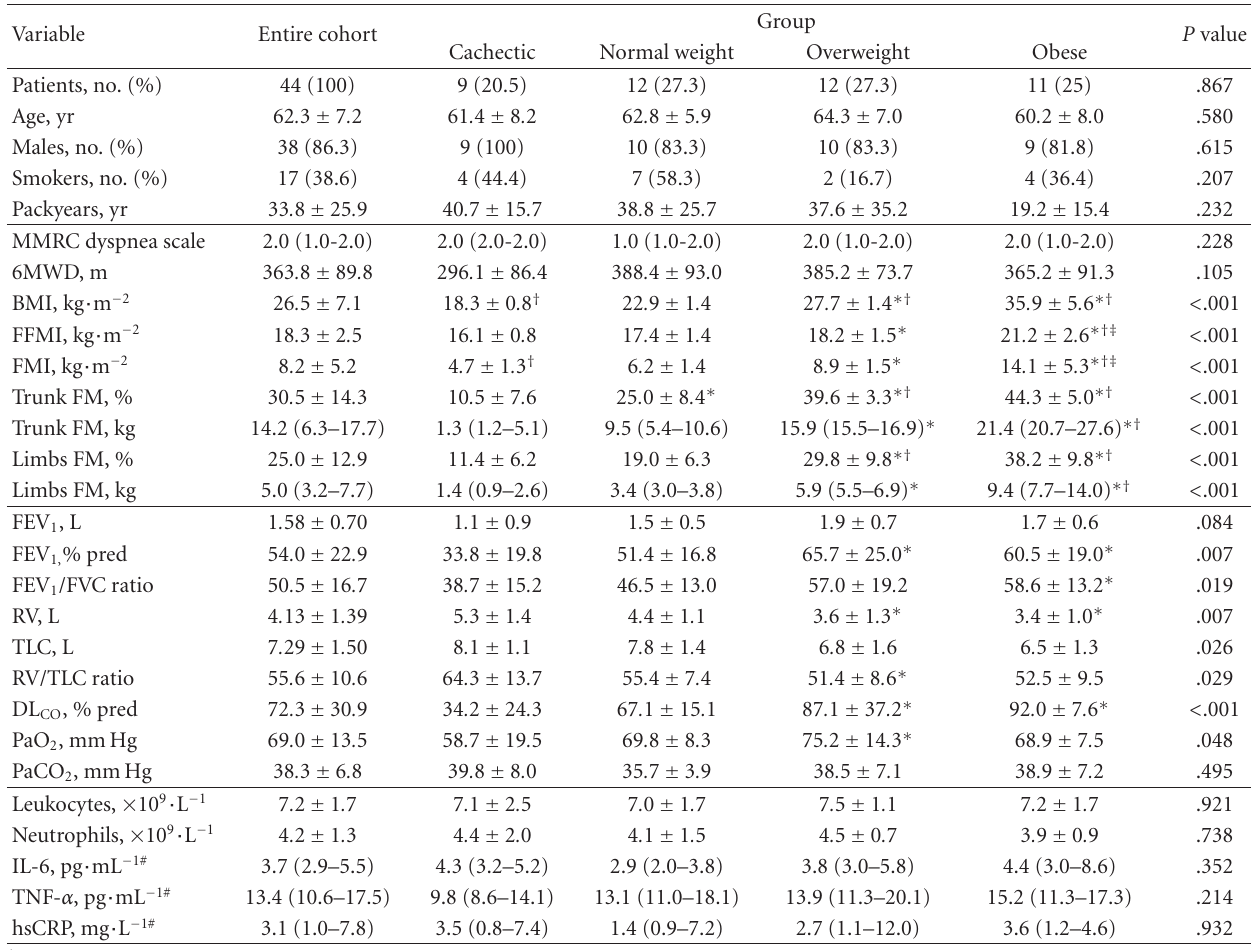
∗ P < . 05 versus cachectic group. †